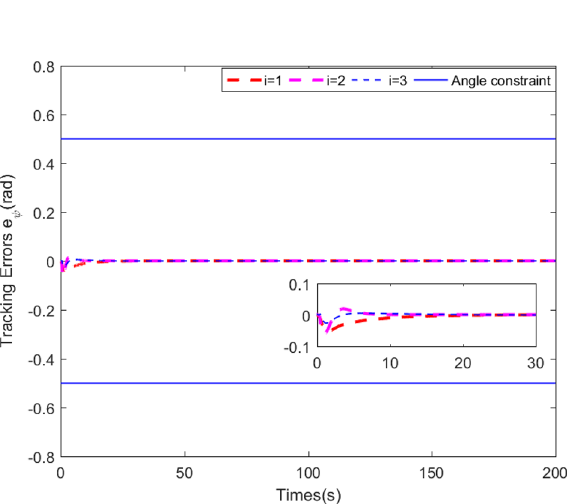
Figure 4. Evolution of LOS ranges along with the predefined boundaries.